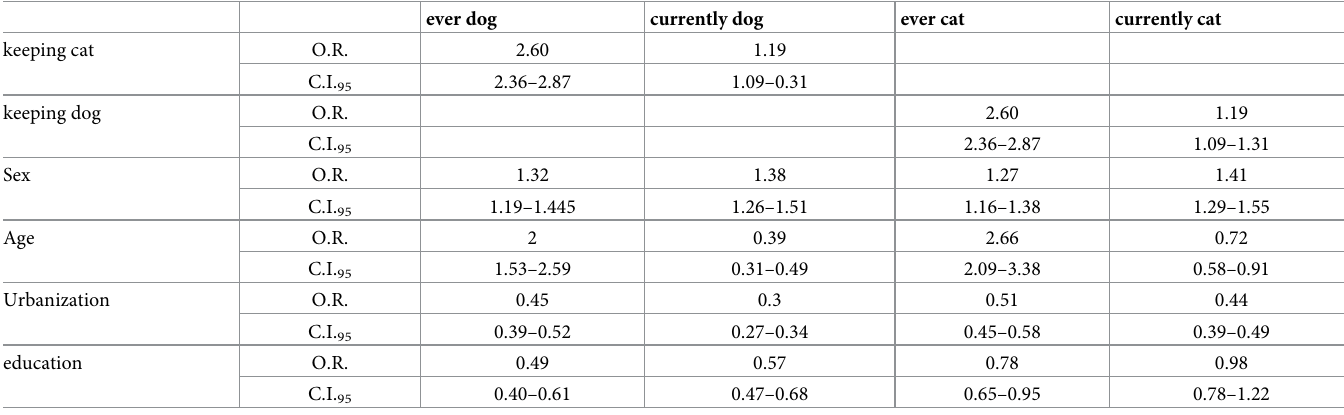
Table 1. Predictors of keeping cats and